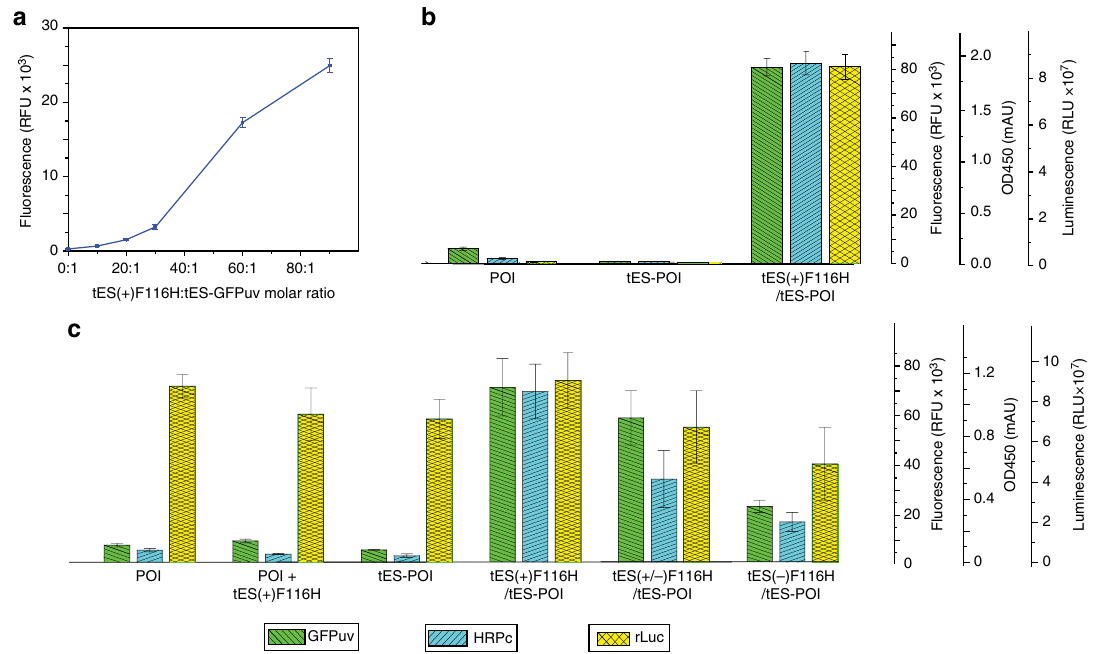
Fig. 2 Effects of tES variants on the functional yield of internalized peptides. a Effect of different molar ratios of tES(+) subunits to tES-GFPuv on GFPuv activity using in vitro folding. b Functional analysis of the in vitro-folded GFPuv, HRPc, and rLuc in the presence and absence of tES by measurement of fl uorescence, absorbance, and luminescence, respectively. c Analysis of GFPuv, HRPc, and rLuc under a combination of coexpression conditions measured by fl uorescence, absorbance, and luminescence, respectively (details in Fig. 1b). All experiments were performed in triplicates. Error bars represent means